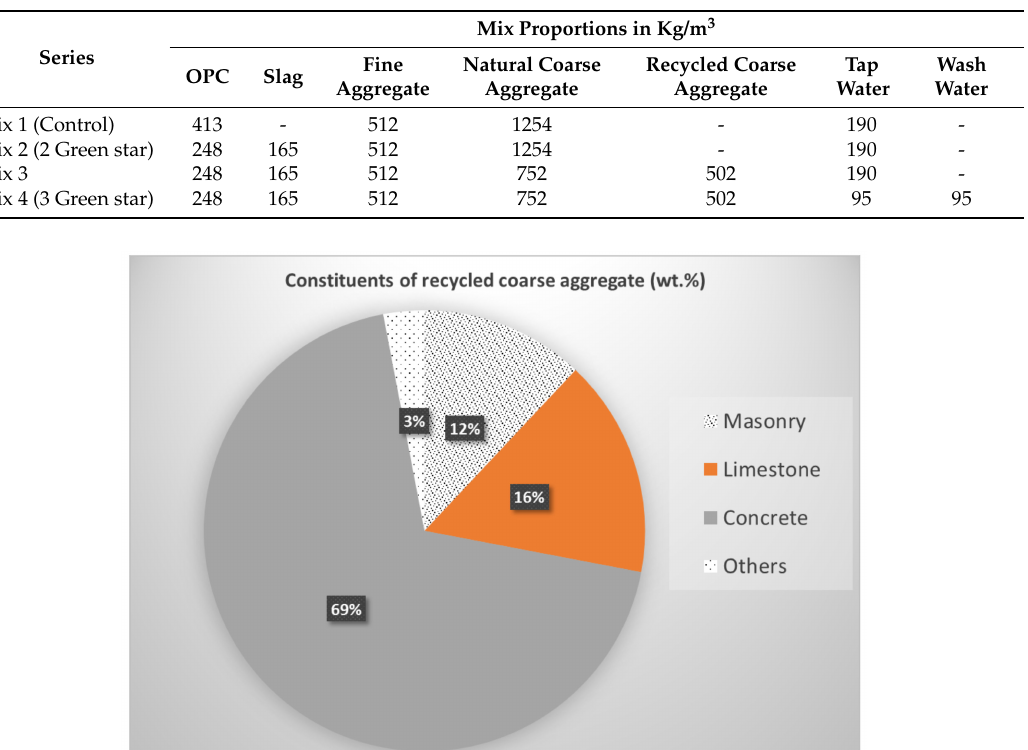
Table 1. Mix proportion of concretes.